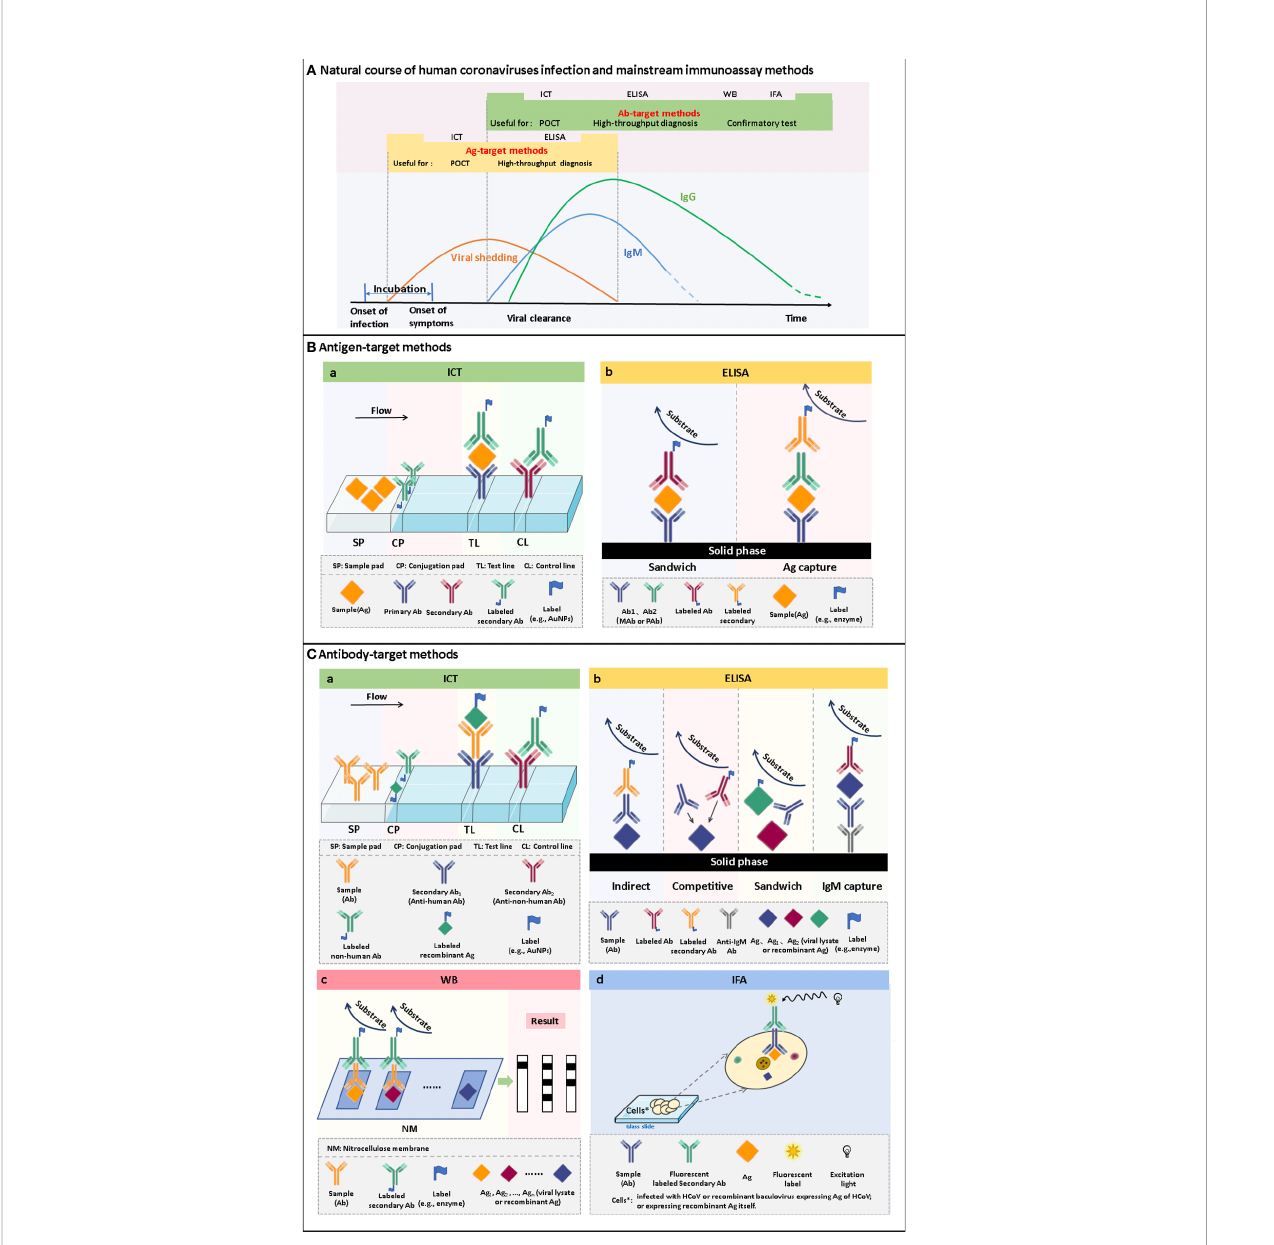
FIGURE 2 The time windows of viral shedding, and antibody responses against HCoVs infections, and the principles of the mainstream immunoassay methods. (A) A typical course of human coronavirus infection. The infection starts with an asymptomatic incubation period. Viral shedding begins during the incubation period and continues for some time after antibody production. Antibodies are produced a few days after infection. Among the antibodies, IgM appears within a few days after infection and can persist for several months. IgG is produced shortly after the appearance of IgM and persists for a longer time. Antigen-target methods, including ICT and ELISA, can be used to screen infected persons during viral shedding. It can realize the differentiation of latent infection and the early diagnosis of disease. After seroconversion occurs, antibody-target methods, including ICT, ELISA, WB and IFA, can be used for diagnosis. It can be used for acute-phase diagnosis as well as epidemiological investigation. (B) Schematic of ICT and ELISA for the detection of antigens. (C) Schematic of ICT, ELISA, WB and IFA for the detection of